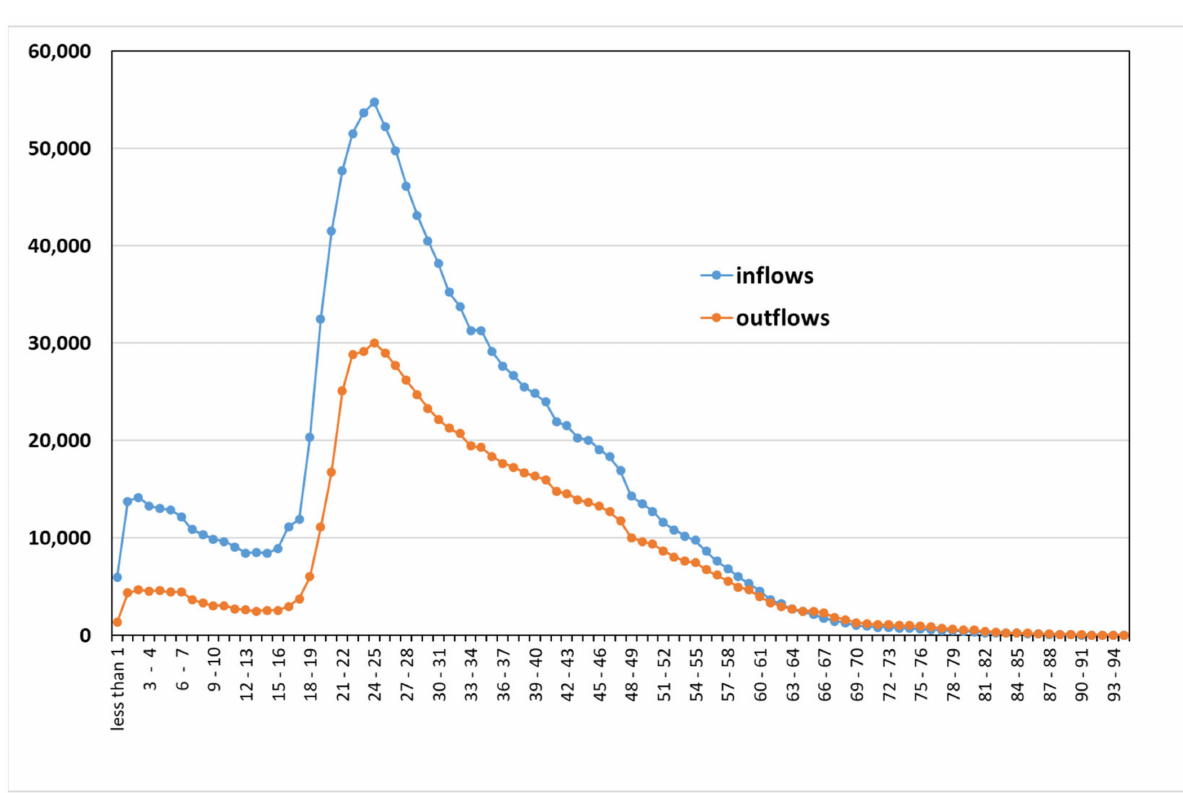
Figure A1. Age-specific gross migration between Germany and other countries in 2014. (Sources: [71]; own computation and